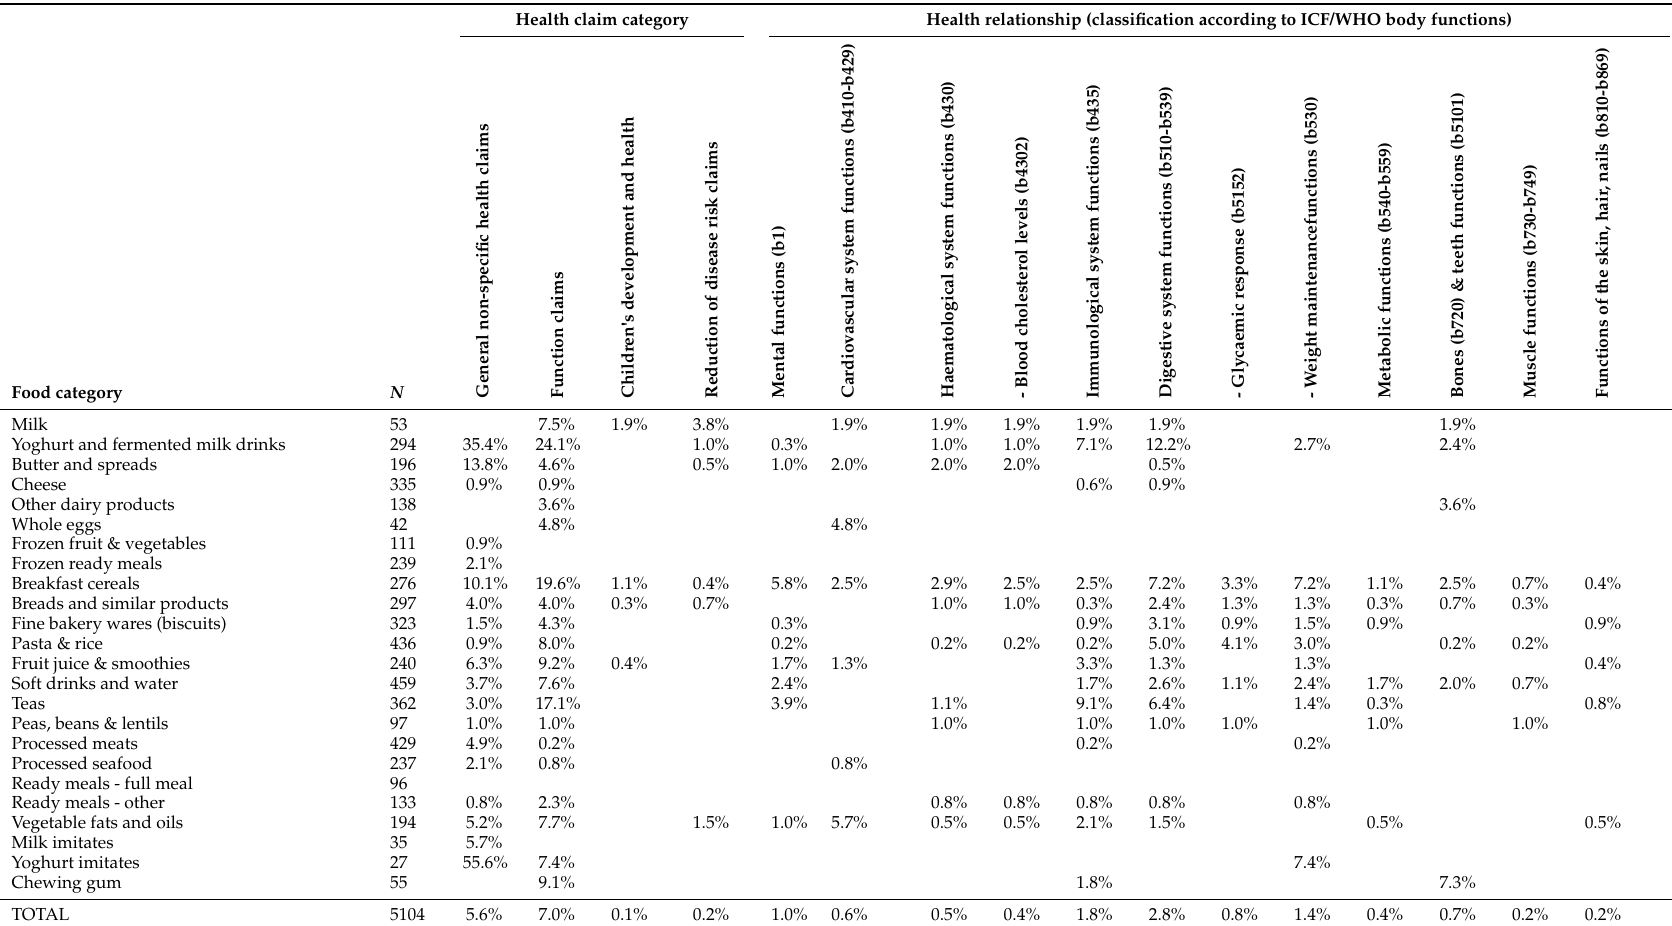
Table 4. Proportion of pre-packed foods (per food category) with different categories of health